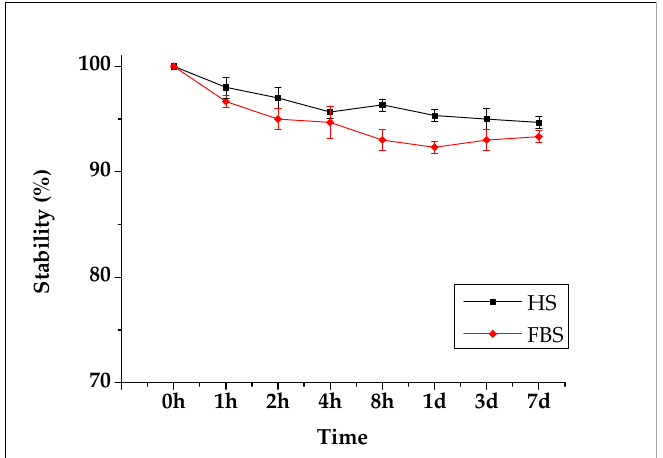
Figure 7. Biological stability evaluation conducted using human serum (black line) and fetal bovine serum (red line). Measured for 7 days using an automatic gamma counter (n = 3).